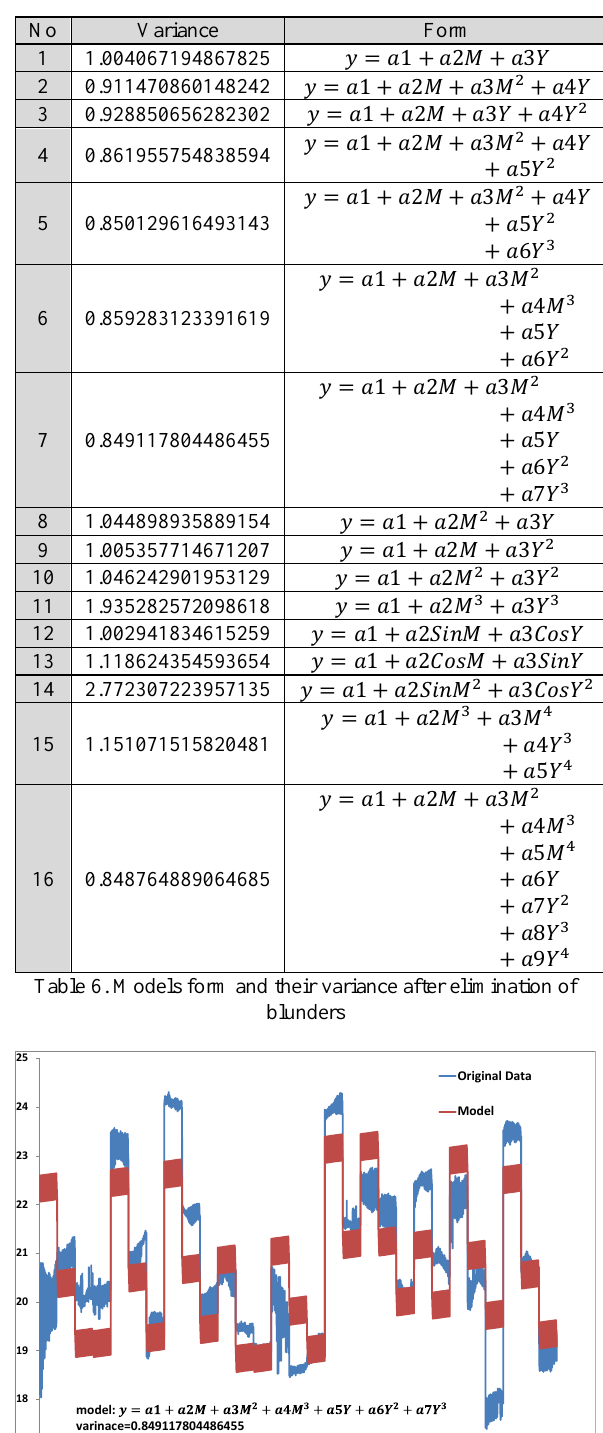
Figure 3. Compare model no. 7 outputs after elimination of blunders with SST data in MCSST method, where blue line is MCSST data and red line is output model Where: M= month Y=Year y=SST based on output model no.